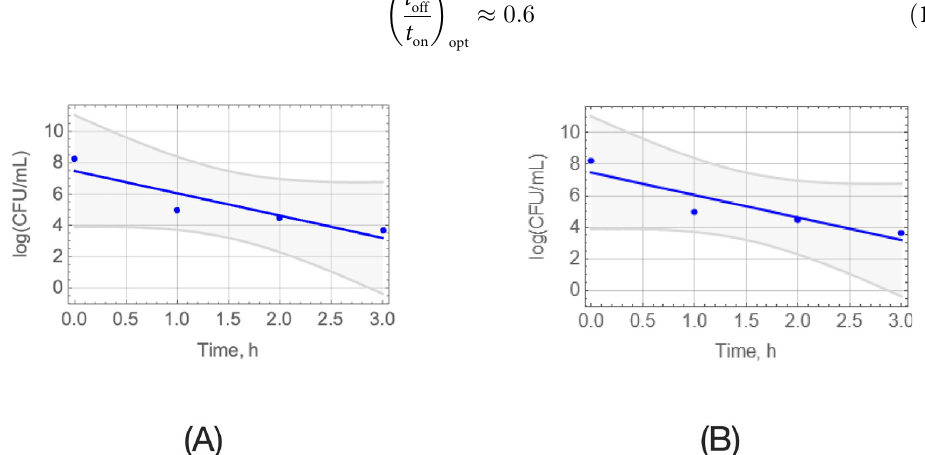
Fig 5. Time-growth (a) and time-kill (Ampicillin at 100 μ g/mL) (b) experiments for generation of data to assess t on / t off for design of pulse dosing. 95%-confidence bands are shown. The slope of the cyan straight line (a) indicates the initial slope of the blue line and corresponds to K